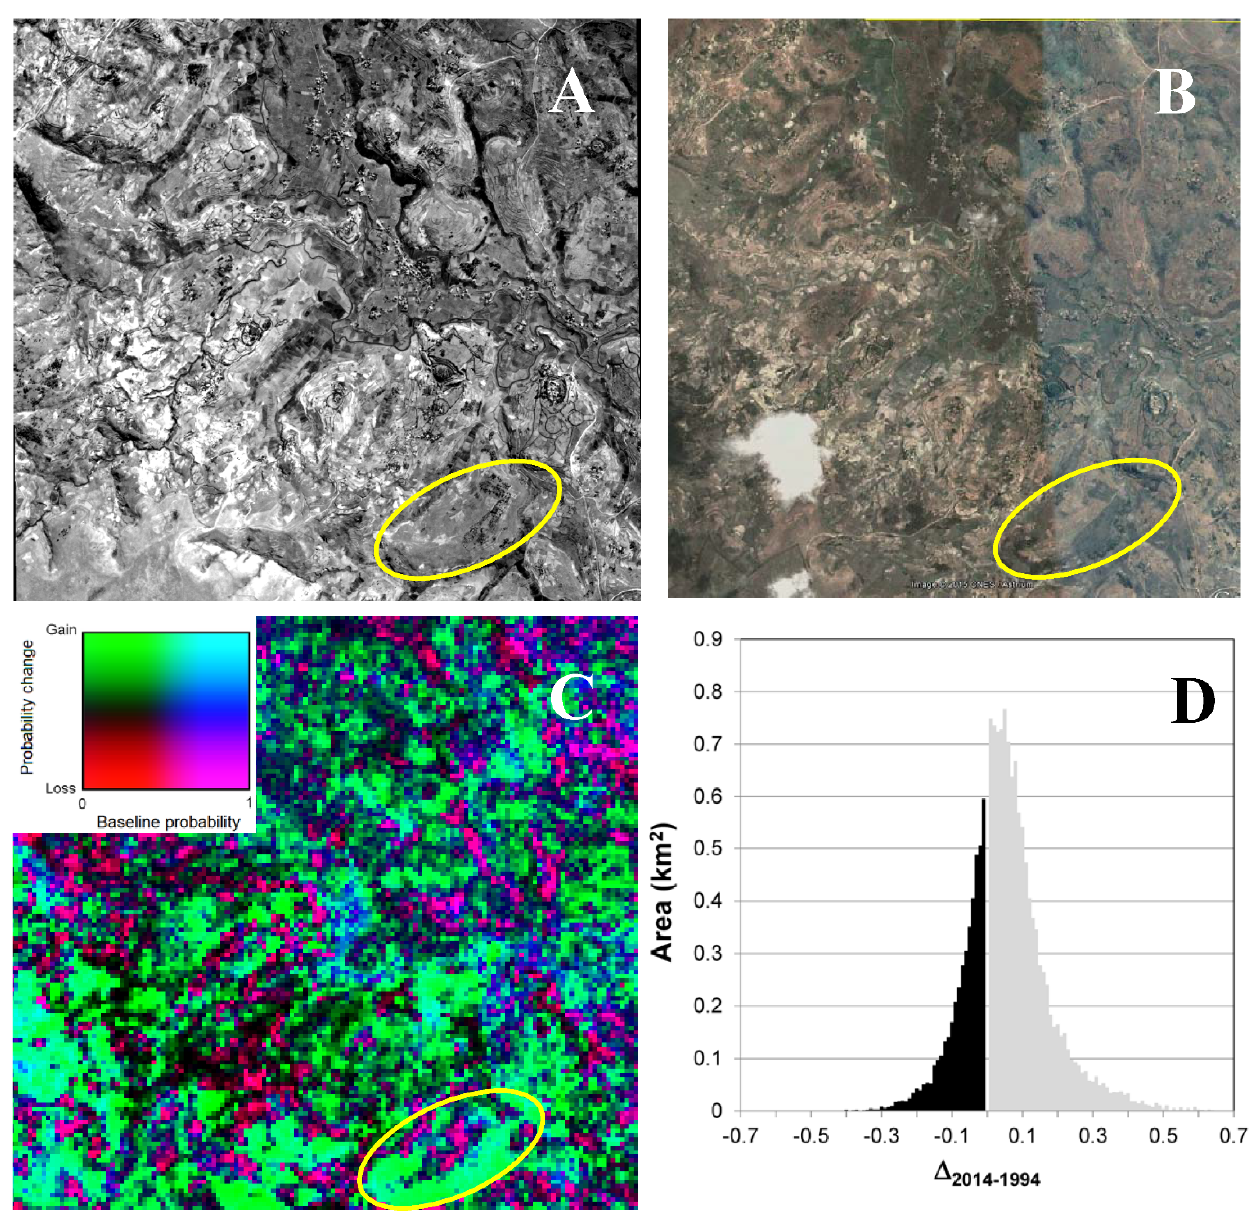
Figure 6. Dynamics of woody cover at Site 04, Ambohijatovo, centered on a rice cultivating valley just south of Anstirabe (19°56'S, 47°0'E). ( A ) Aerial photograph taken in 1991. ( B ) CNES Astrium imagery taken in 2013. ( C ) Change map based on Landsat imagery (see Figure 2). ( D ) Histogram depicting the frequency distribution of the delta of woody cover probability values between 2014 and 1994 based on Landsat imagery. Woody cover loss is represented in black, while gain is represented in gray. Ellipses in (A–C) relate to a particular woody cover dynamic described in the text. See Figure 1 for the geographic location of Site 04 within the study